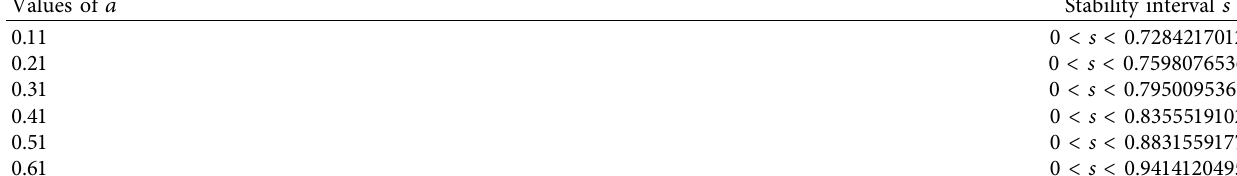
Table 1: Controllable interval for model (120) with various values of a .